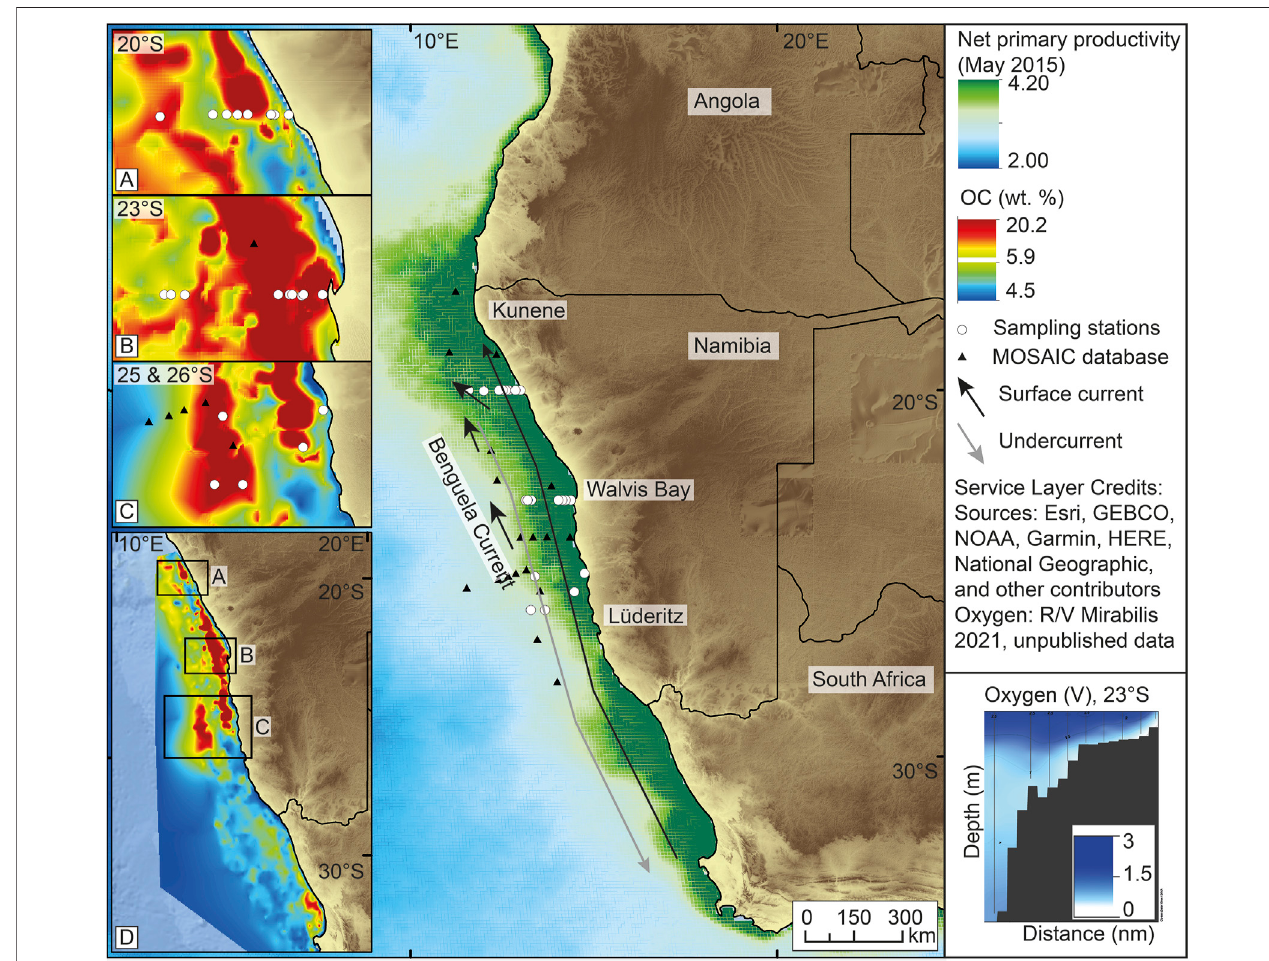
FIGURE 1 | Overview of study area (large right panel), including the three BUS upwelling cells that were studied boxes (A – C) . Black symbols refer to MOSAIC database stations (Van Der Voort et al., 2021). Stations shown as white circles were analysed in this study. On the shelf, two large currents con fi ne the BUS: an undercurrentfrom thenorth(nutrient-poor,oxygen-rich)andasurfacecurrentfrom theAngolaGyre (nutrient-rich, oxygen-poor)(modi fi edfromNCEI — National Centers for Environmental Information, 2016). Ocean colour (NPP, 4 km resolution) shows the typical distribution of high productivity inshore (NASA, 2018) and thus highlights the major upwelling zones. Total organic carbon (TOC; left panels) is focused in belts along the coast and is additionally transported to and concentrates in depositional centres ( “ depocenters ” ) offshore the major upwelling cells (D) . The highest TOC values are present in muddy depocenters 20 and 50 nm offshore Walvis Bay (B) and Lüderitz (C) , respectively (data from Inthorn et al., 2006b). Bottom water oxygen concentrations are low across the shelf and reach minimal values on the platform between 50 and 100 m water depth (e.g., Lavik et al., 2009).